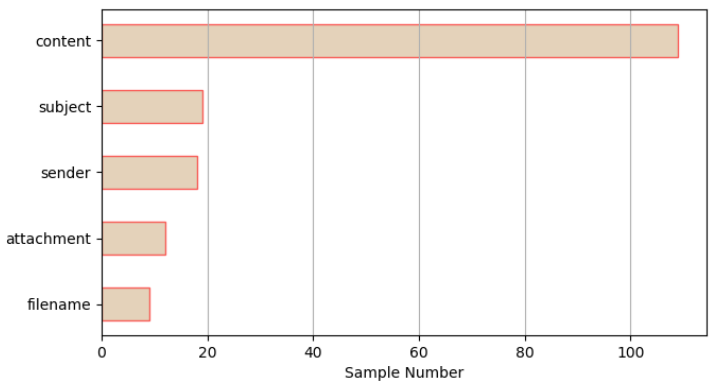
Figure 5. Field types in malicious